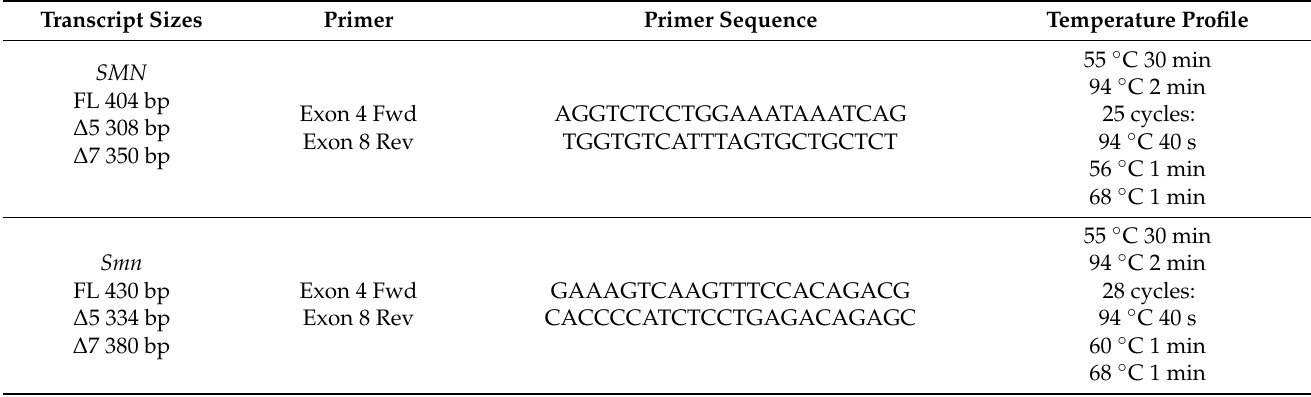
Table 2. PCR conditions for human SMN and mouse Smn transcript